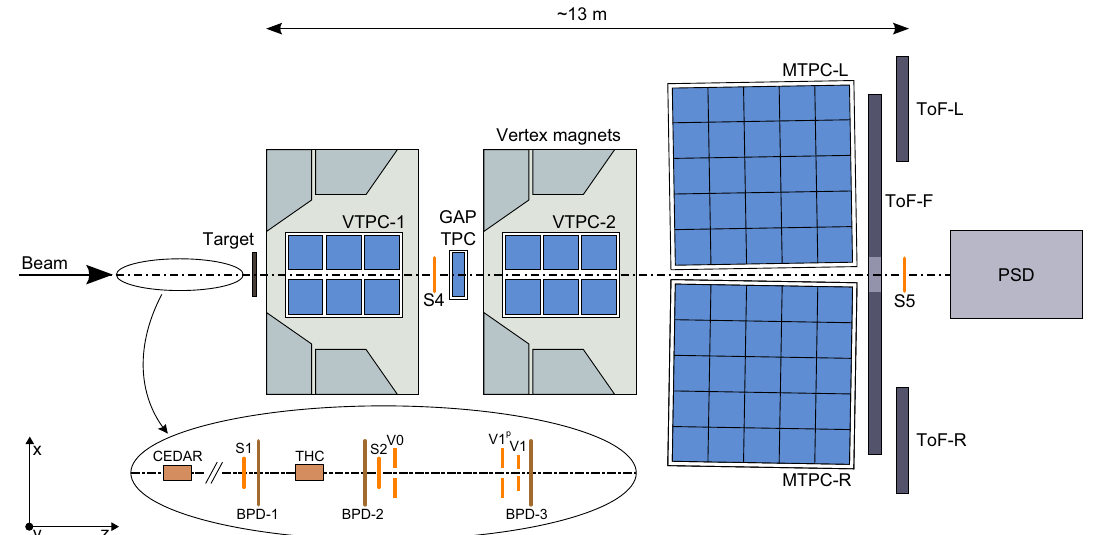
Fig. 1 The schematic layout of the NA61/SHINE experiment at the CERN SPS (horizontal cut, not to scale). Alignment of the NA61/ SHINE coordinate system is shown on the plot. The nominal beam